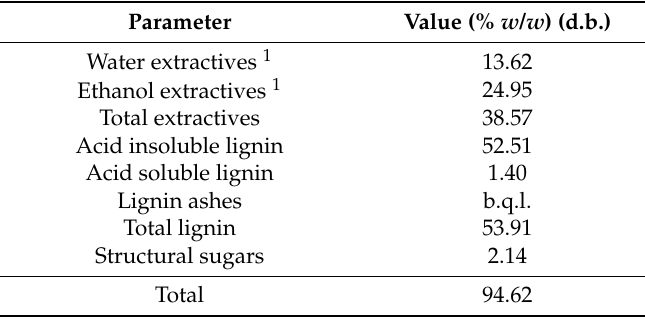
Table 3. Results from the lignin content